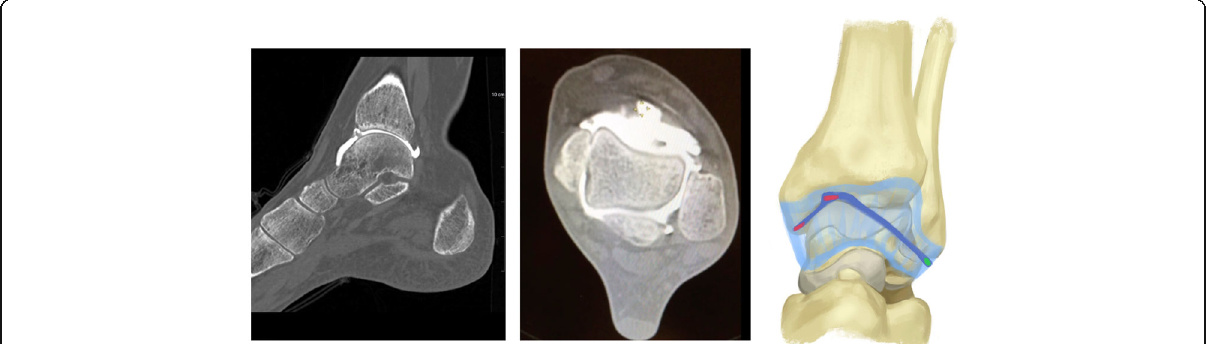
Fig. 2 Sagittal and axial CTA views, and the shape of the fibrous band in patient